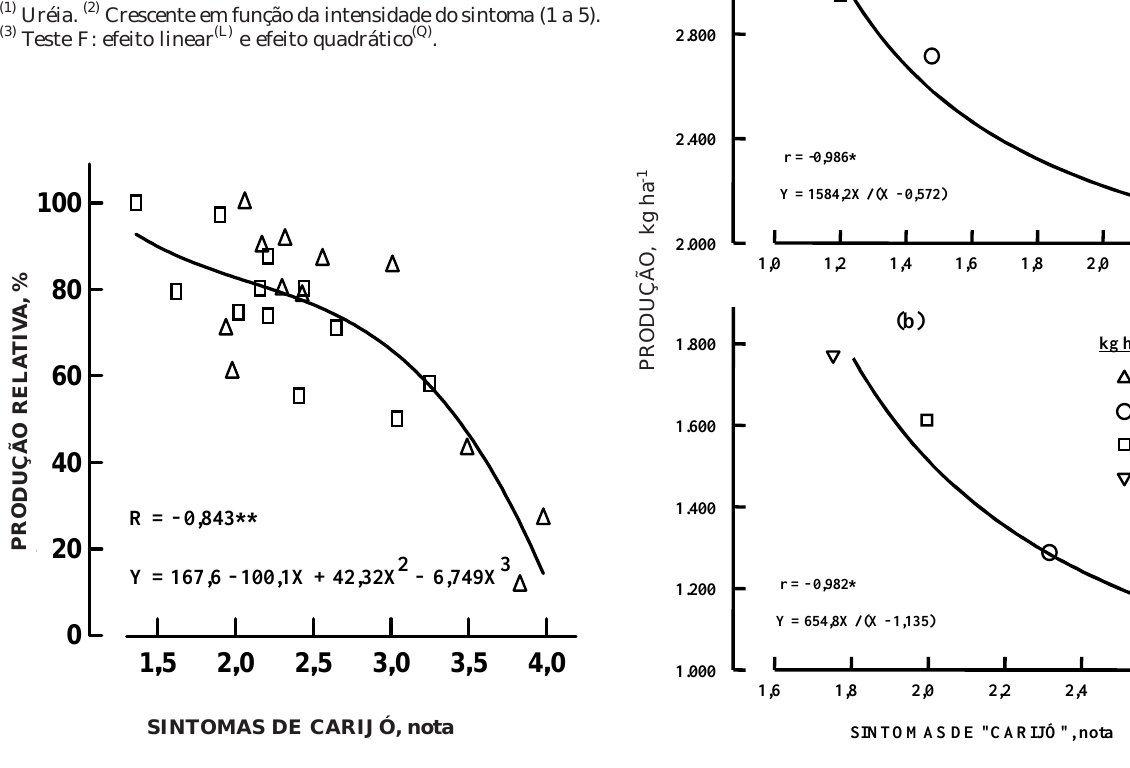
Figura 2. Relação entre a produção de algodão em caroço e a intensidade do “carijó”, considerando as médias obtidas por nível de adubação nitrogenada em cobertura, em Mococa (a) e